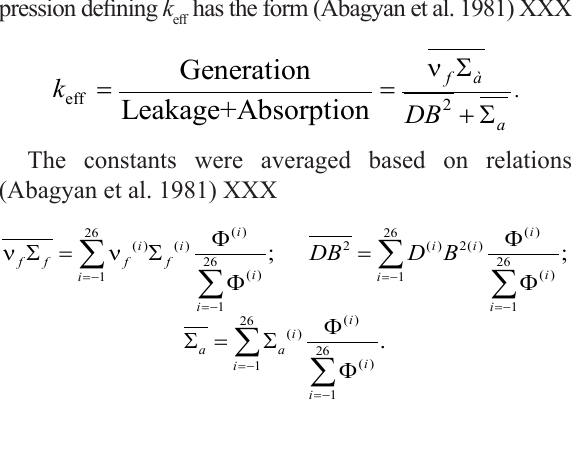
Table 1. Neutronic characteristics of the PuO Parameter